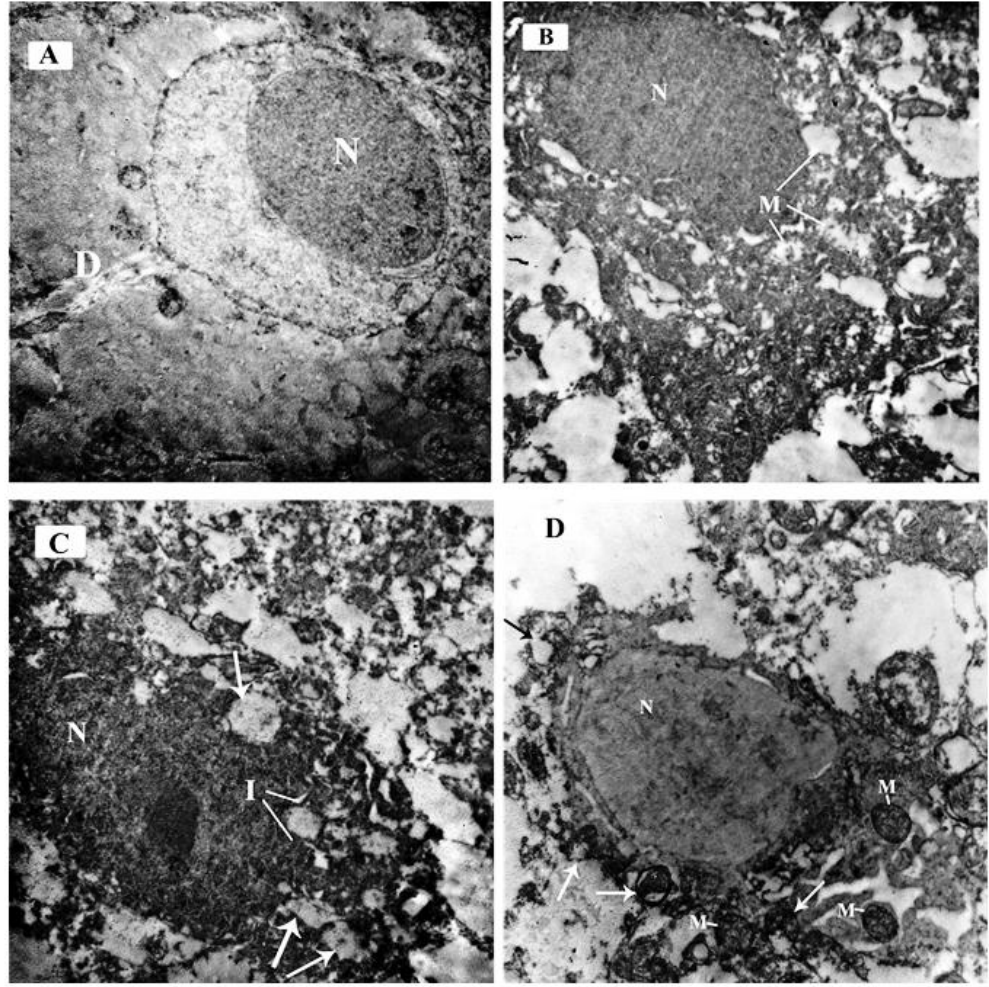
Figure 10. Electron micrographs of the mouse cerebellar cortex in different study groups at the Purkinje cell layer; ( A ) control group and ceftriaxone group; Purkinje cell has a euochromatic nucleus (N) with fine dispersed chromatin and a well-formed bi-laminar nuclear envelope. The cytoplasm contains scattered cell organelles. A primary dendrite (D) is also seen projecting from the cell membrane. ( B ) ARS group; Purkinje cell having a dark electron-dense nucleus (N) with an irregular nuclear membrane. The cytoplasm contains many swollen mitochondria showing rarified matrix with fragmented or lost cristae (M). ( C ) ARS group displays markedly affected Purkinje cells. The nucleus is shrunken, darkly electron dense, and irregular in shape with indentation of its nuclear membrane (I). Many dispersed irregularly shaped chromatin aggregates are demonstrated throughout the nucleus. The cell has irregular outline with shrinkage cytoplasm containing multiple ballooned mitochondria (arrows) with disrupted cristae. ( D ) ARS + ceftriaxone group; Purkinje cell exhibits a euochromatic nucleus (N) and fine dispersed chromatin. The cytoplasm reveals multiple mitochondria comparable to the control (M) while others are disrupted with separated outer and inner mitochondrial membranes (arrows). (× 6000).